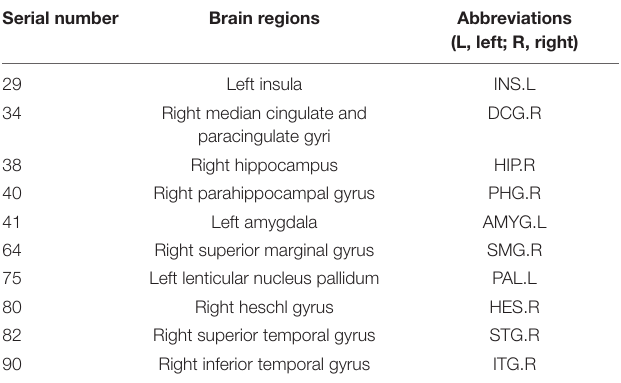
TABLE 5 | Discriminative brain regions.